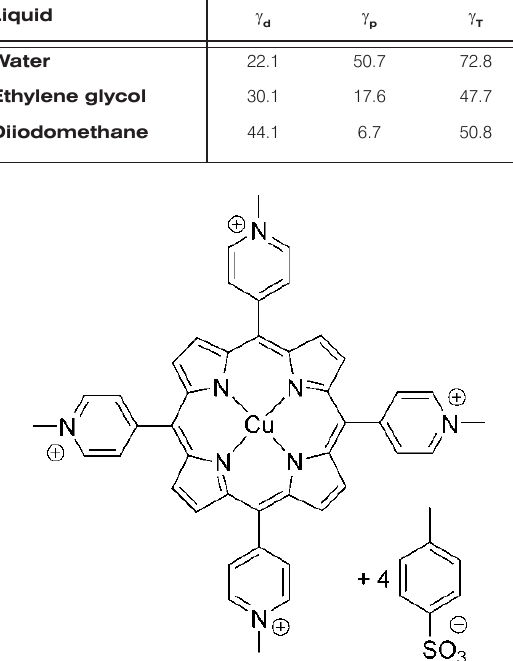
Figure 2. Molecular structure of tetra(N-methyl-pyridinium-4-yl) porphyrinato copper(II) (CuT 4